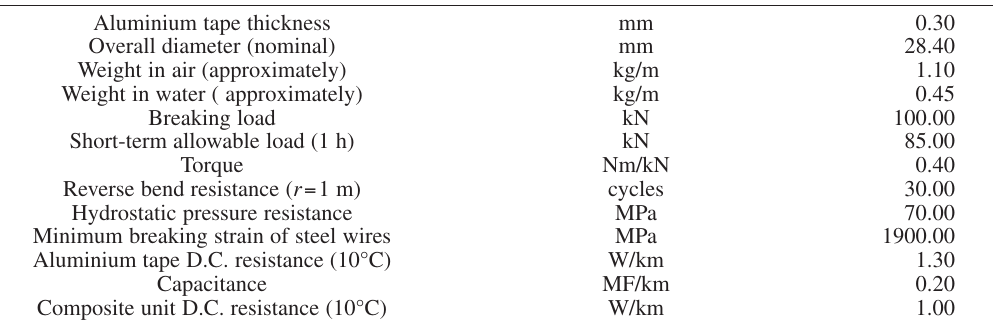
Table III. Main characteristics of LWP 8-fibre